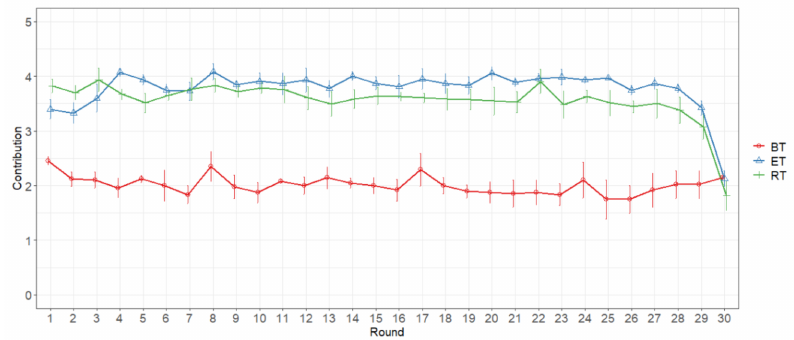
Figure 2. Average contribution and standard error, by round and treatment. Overall, we can conclude that Hypothesis 1 is supported by the